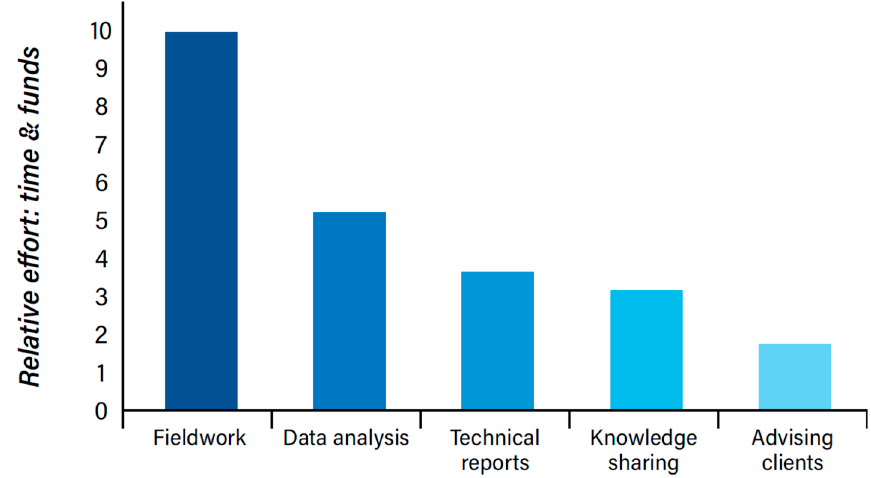
Figure 7. Relative time allocation and funds for different stages along the research to utilization chain. Source: [36].